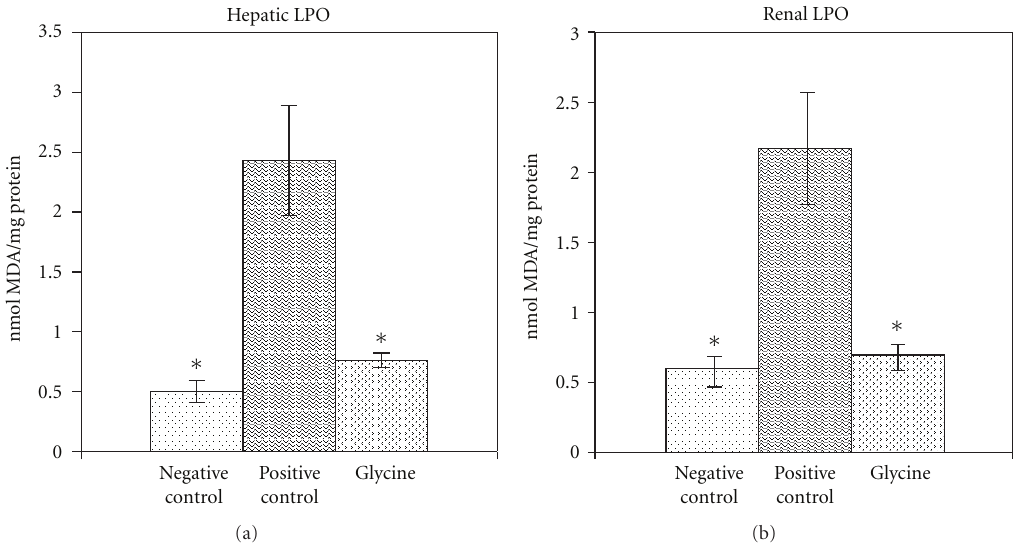
Figure 2: Therapeutic e ffi cacy of glycine (100 mg/kg) on LPO levels in liver and kidney of lead-exposed rats. Values are mean ± SE; n = 5. ∗ P < 0 . 05 compared with positive lead